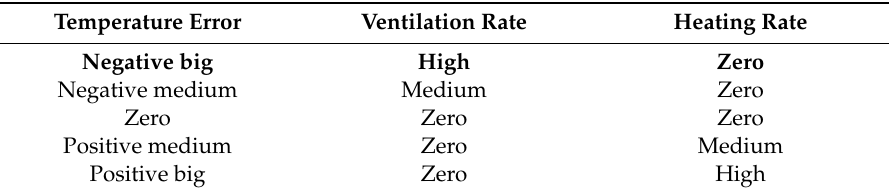
Table 1. Fuzzy rules for temperature control.